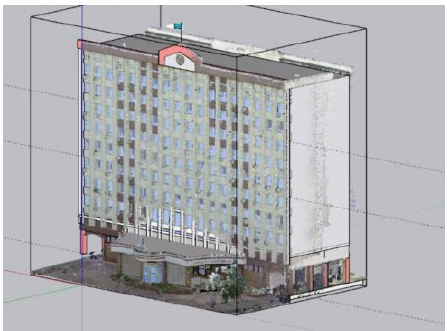
Figure 10. Point cloud in SketchUp software loaded using the Undet module.